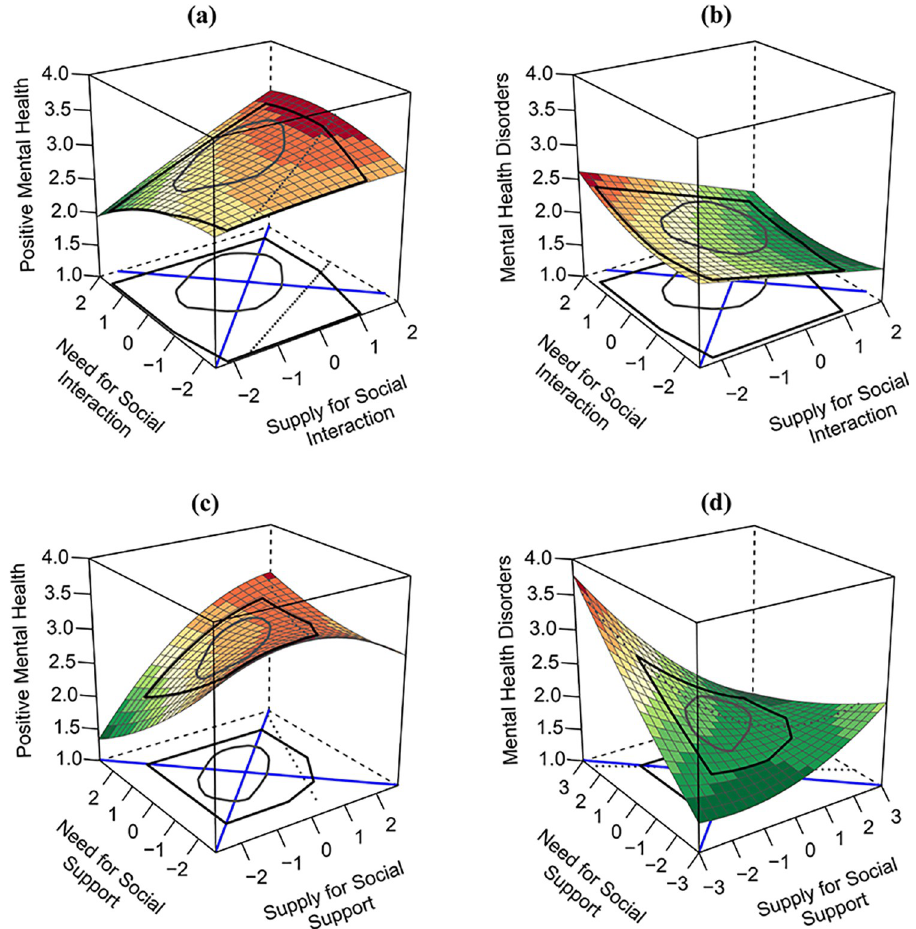
Fig 2. The impact of social connection measures on measures of mental health, displayed in four response surface plots. Note . Surface plots a) and b) assess the needed social interaction ( x axis) and supplied social interaction ( y axis), and c) and d) assess the needed social support ( x axis) and supplied social support ( y axis). Surface plots a) and c) predict positive mental health ( z axis), and b) and d) predict mental health disorders ( z axis). Colour scheme: Darker shades of red indicate higher values within each plot, and darker green shades indicate lower